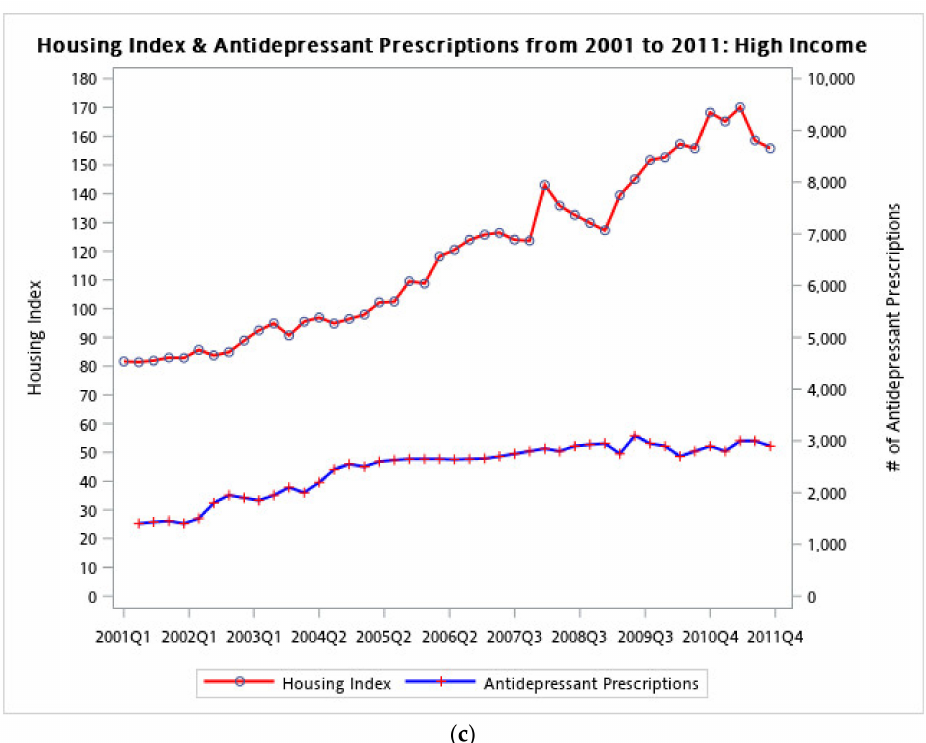
Figure 4. Line plot of housing indexes and antidepressant prescriptions stratified by income: ( a ) hous- ing index and antidepressant prescriptions for low-income subgroup; ( b ) housing index and an- tidepressant prescriptions for middle-income subgroup; and ( c ) housing index and antidepressant prescriptions for the high-income